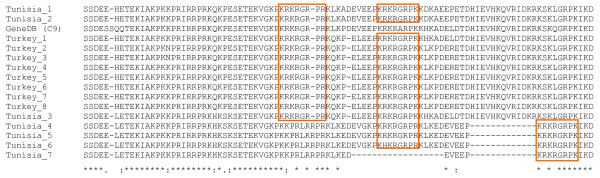
DNA binding motifs in SuAT1. Amino acid sequences representing alleles of SuAT1 were aligned and DNA binding motifs termed 'AT-hooks' are highlighted in orange. Block differences distinguish the five Tunisian alleles at the bottom of the alignment and the Turkish-derived alleles. The Tunisian sequences Tunisia_1 and Tunisia_2 and the C9 sequence (Turkey) at the top of the alignment are intermediate between the archetypal Tunisian and Turkish alleles.